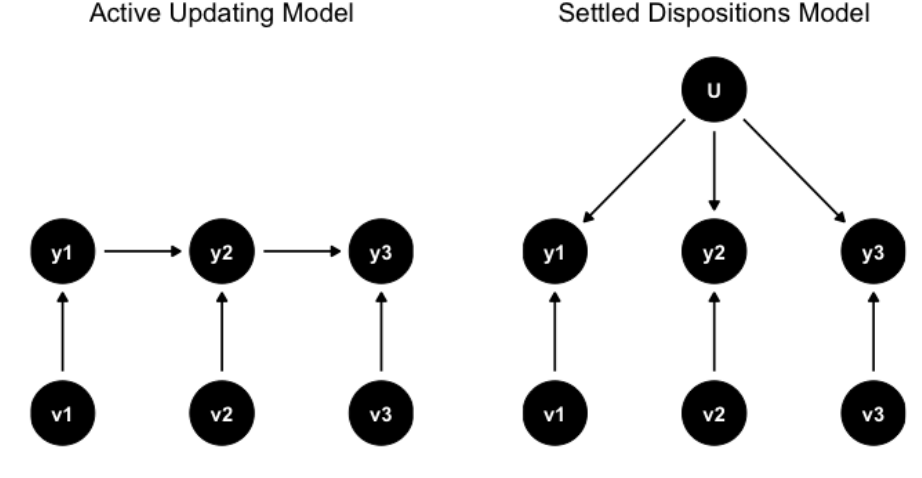
Figure 1: Theoretical